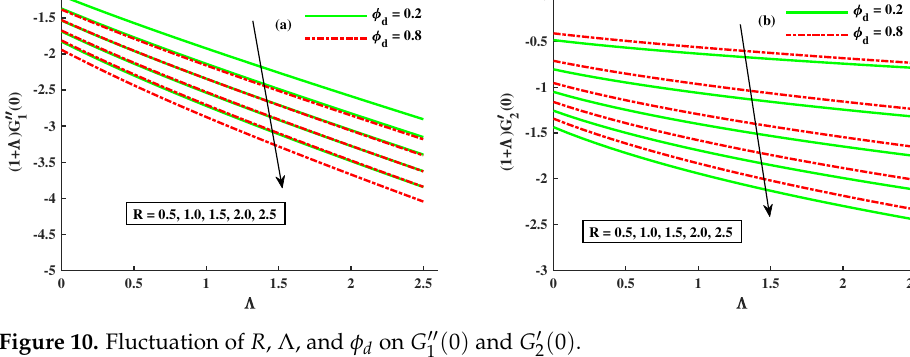
( 0 ) and G (cid:48) ( 0 ) . 2 1